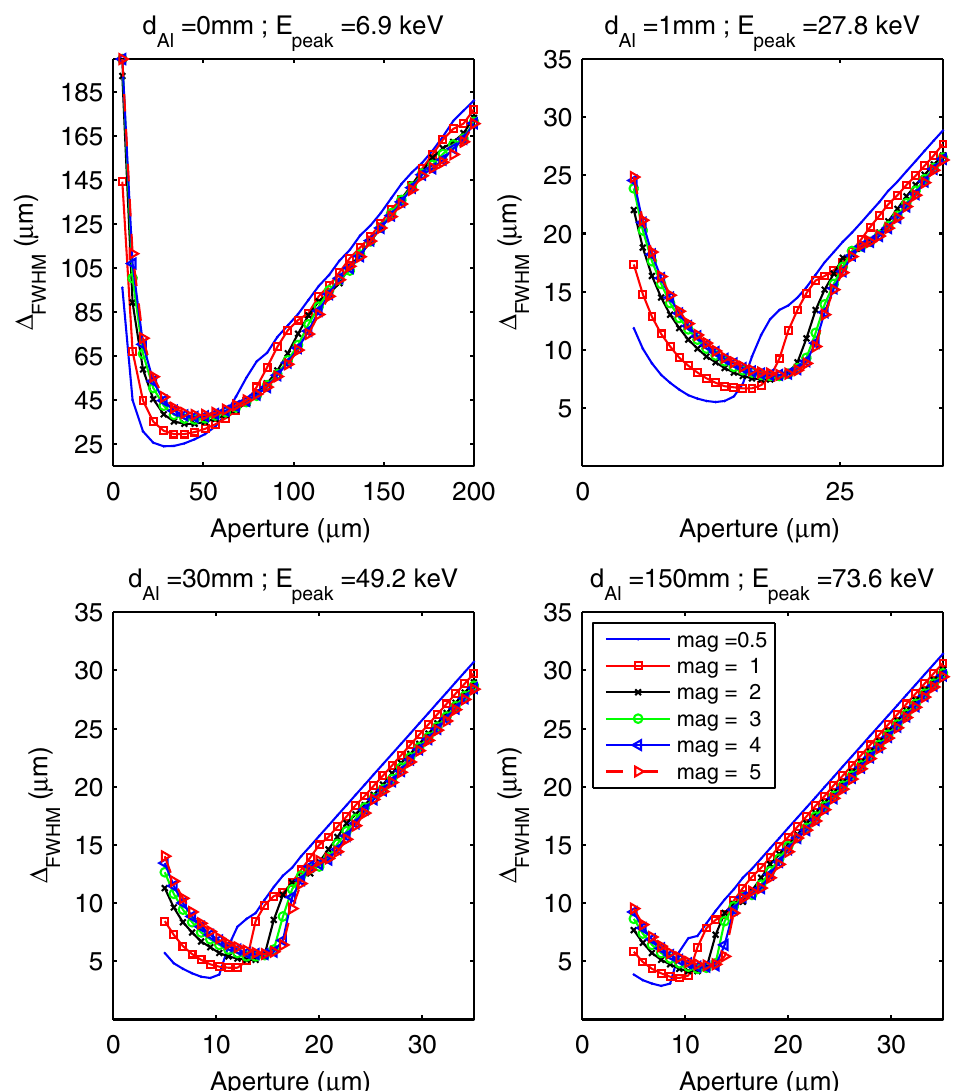
FIG. 10. (Color) Dependence of the PSF (FWHM) of the pinhole as a function of the aperture, and for several magnifications and several spectra (related to the filtering from air and Al thickness). The peak of the spectrum is indicated. In the first case, with no Al filter, we consider the case of a pinhole in vacuum. The distance source pinhole is 3.8 m and the distance pinhole screen varies. After the Al window, at the pinhole, the beam is further filtered by